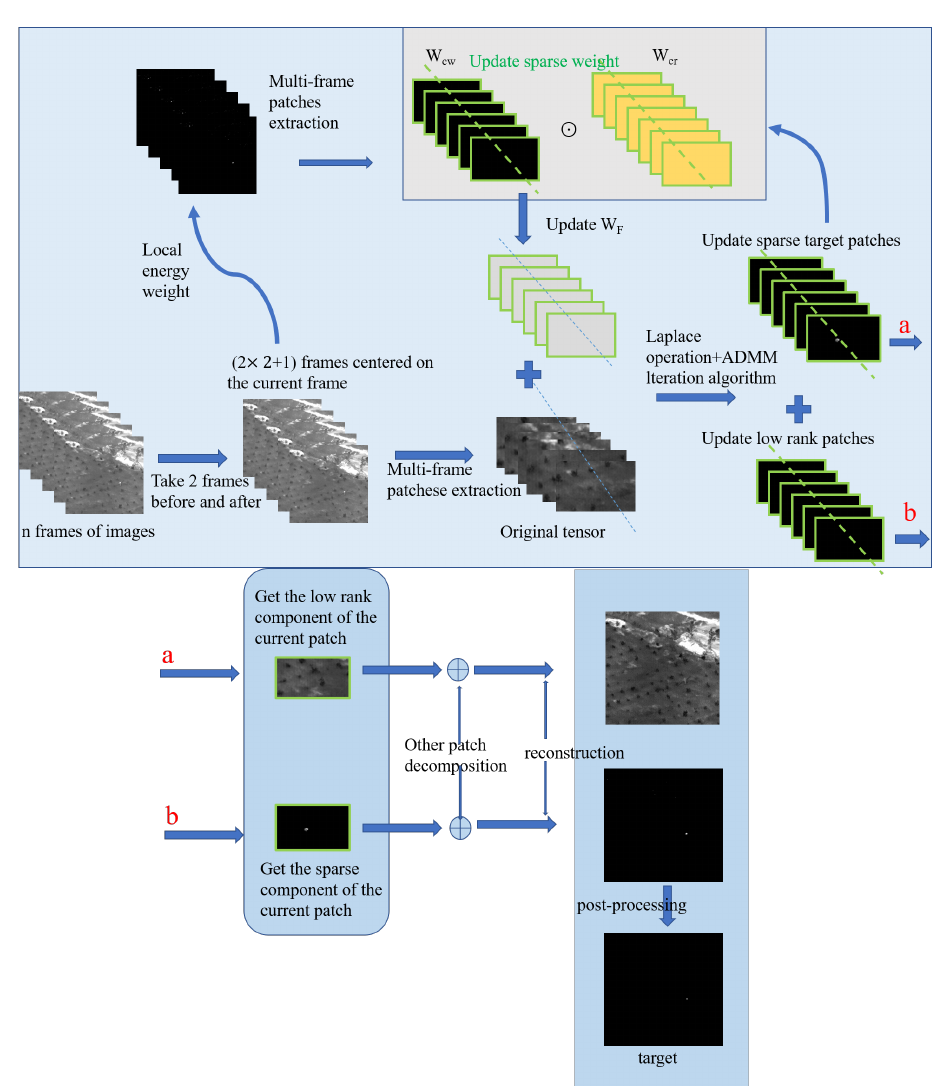
Figure 8. Flowchart of the proposed method. a and b in the picture above are connected to a and b in the picture